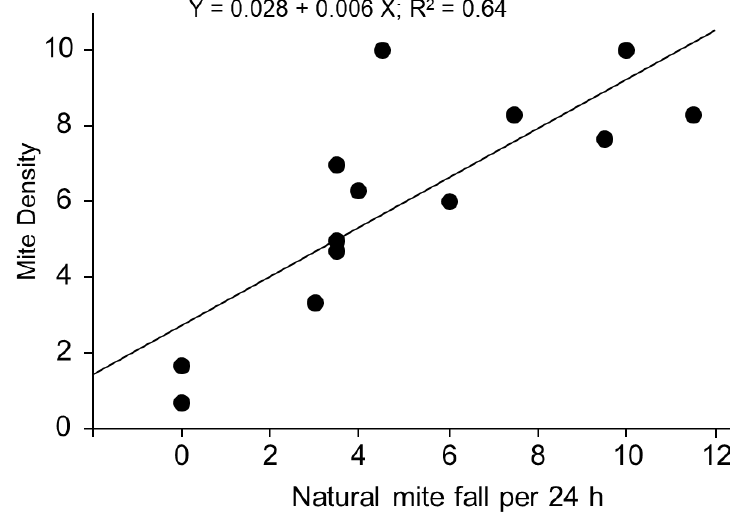
Figure 1. There was a significant correlation (regression analysis, p < 0.01) between natural mite fall and mite and mite density.